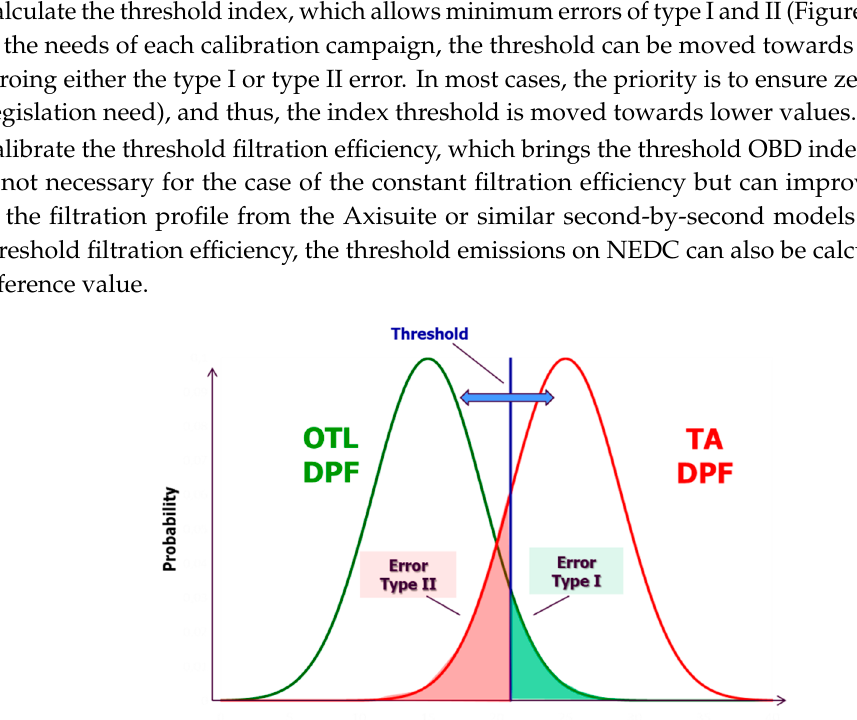
Sensors 2019 , 19 , x 12 of 23 targets the minimization of the number of false failures (error of commission, type I error) according to the industrial standards (close to zero errors of commission) because otherwise, it would lead to unnecessary costs for technical inspection and customers complaints. In this case, the threshold should be as close to the OTL (12 mg/km) as possible. Therefore, a compromise between the two design competing targets is necessary for real-world applications and the model and the efficiency need to be calibrated with respect to this requirement. The final threshold emissions should be as close to the OTL as possible according to the above theory (e.g., 9